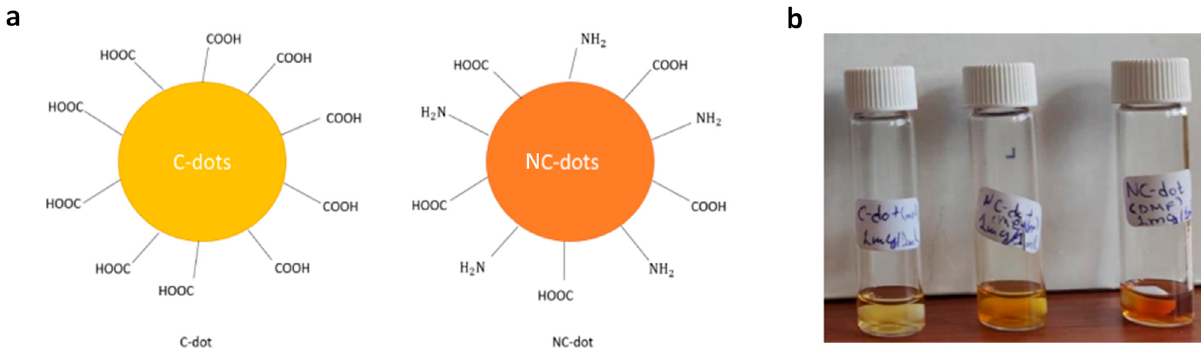
Figure 1. ( a ) Illustration of the chemical structures (surface functionalization) of C-dots and NC-dots. ( b ) Photographs demonstrating the solution processability of carbon nanodots. From left to the right: a methanol solution of C-dots, a methanol solution of NC-dots and a DMF solution of NC-dots.